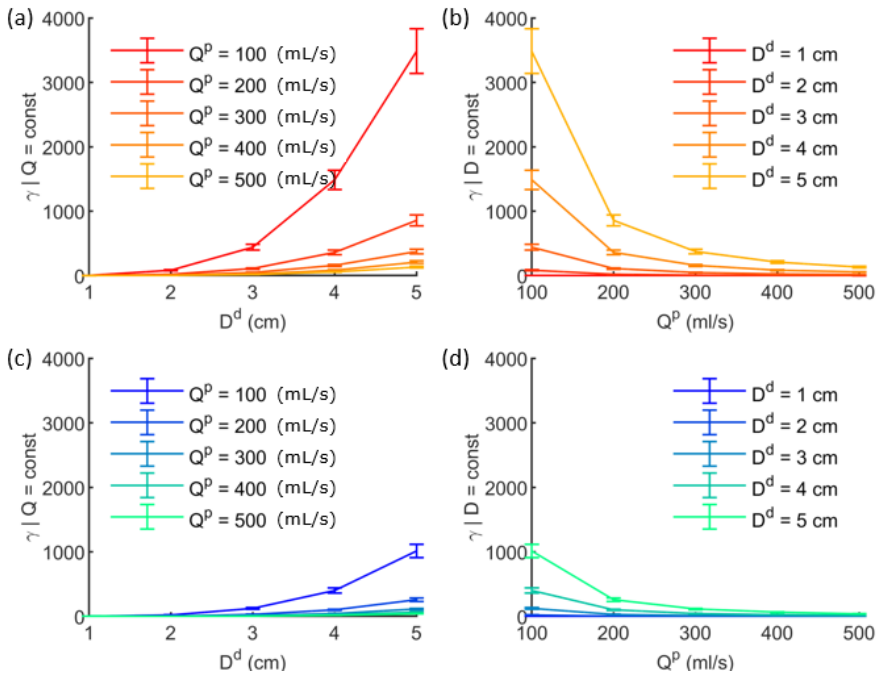
Figure 6. ( a , b ) Trend of γ | Ao with respect to diastolic diameter at constant flow ( a ) and vice versa ( b ); ( c , d ) Trend of γ | PA with respect to diastolic diameter at constant flow ( c ) and vice versa ( d ).